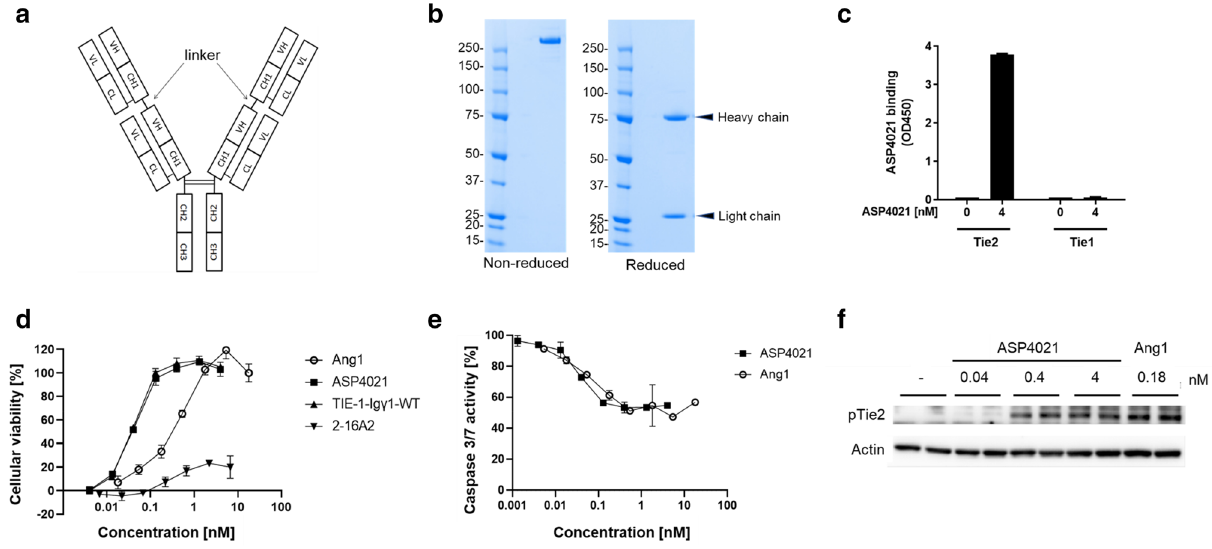
Figure 2. Generation and in vitro evaluation of the tetra-valent anti-human Tie2 antibody. ( a ) Structure of the tetra-valent antibody. ( b ) SDS-PAGE of the tetra-valent antibody under non-reduced (left) and reduced (right) conditions. Molecular weights (kDa) are indicated on the left of each gel. ( c ) Binding activity of ASP4021 to human Tie2 and Tie1 by direct ELISA. ASP4021 binding is shown as the absorbance at OD450. Each value is expressed as mean ± SEM. ( d ) Cellular viability as an indicator of agonistic activity of the tetra-valent and bi-valent antibodies in human Tie2-expressing Ba/F3 compared to Ang1. Cellular viability (%) was determined as described Fig. 1a. ( e ) Anti-apoptotic activity of ASP4021 in human Tie2-expressing Ba/F3 compared to Ang1. Caspase 3/7 activity (%) was calculated using the Caspase-Glo 3/7 assay, with basal activity with IL-3 defined as 0%, and activity without any ligand (PBS) defined as 100%. Data represent mean ± SD. ( f ) Phosphorylation of Tie2 induced by ASP4021 in HUVEC compared to Ang1. HUVEC were treated with ASP4021 or recombinant Ang1 for 30 min. Levels of phosphorylated Tie2 and actin in cell lysates were detected using Western blotting. The assay was performed in duplicate. Full-size versions of Western blots are depicted in Supplementary Fig.